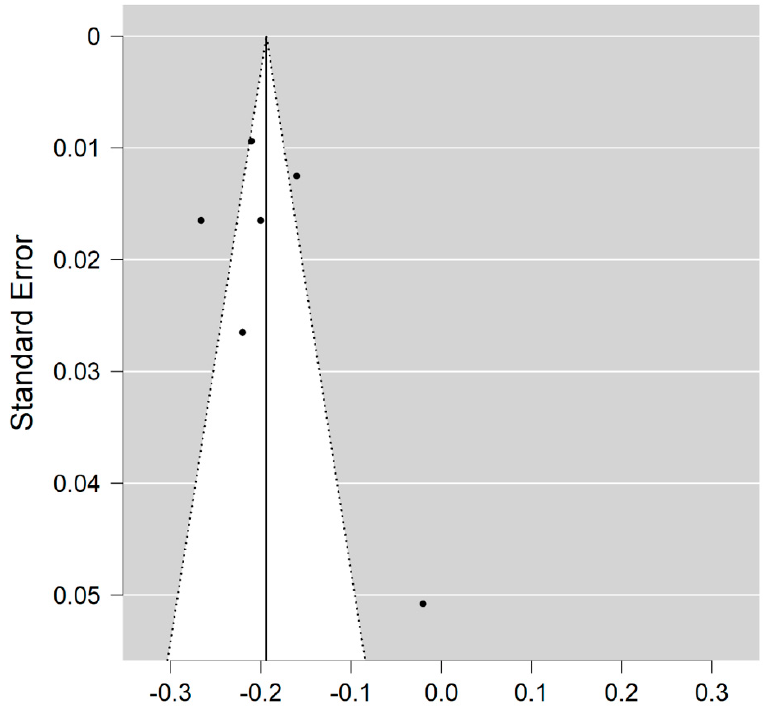
Figure 3. Funnel plot for the NDI in MS WM lesions (MS vs. control).